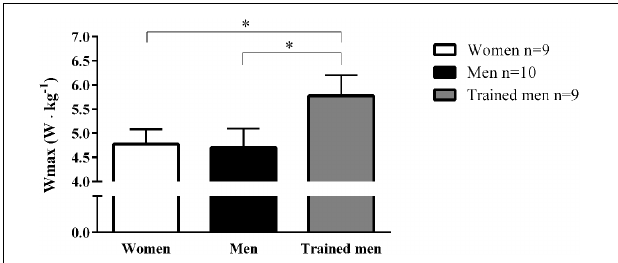
FIGURE 3 | Mean ± SD values of maximal cycling power output (W max ; W kg − 1 ) achieved on a gradual incremental exercise test for women, men, and trained men groups. ∗ p < 0.05 between